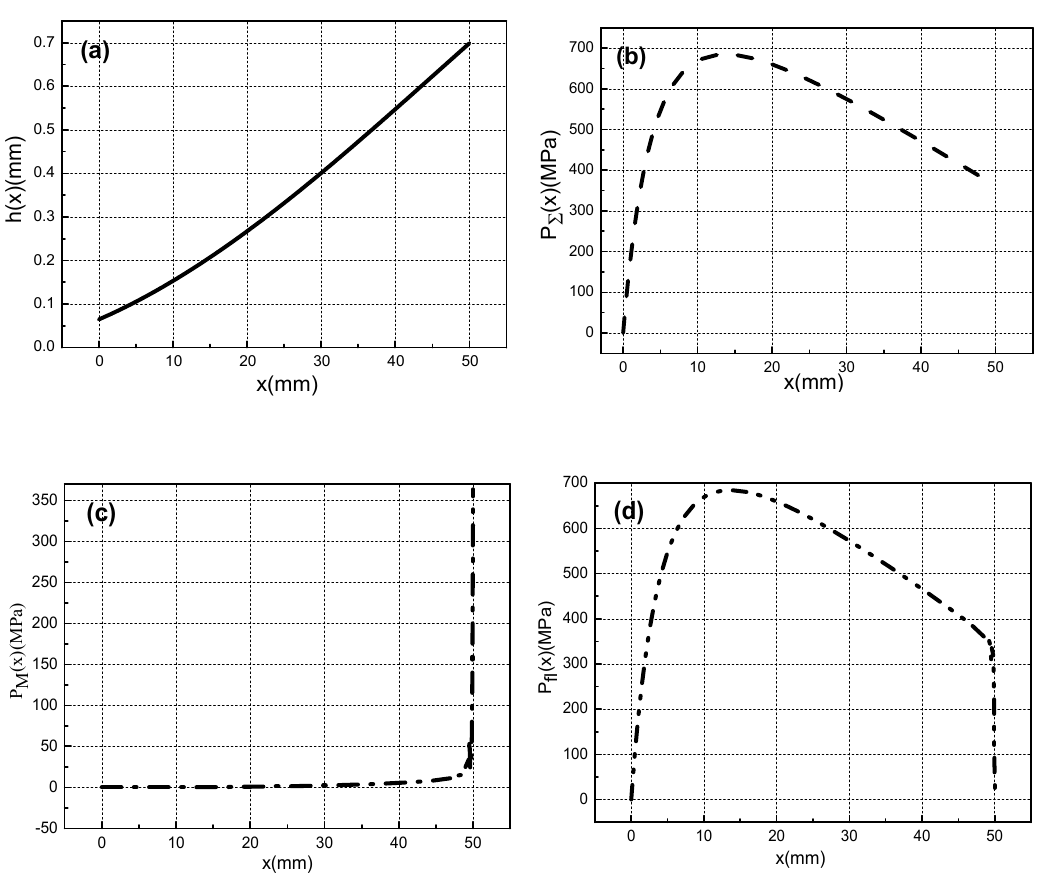
Figure 7. Lubrication characteristics of metal liquid film when the armature movement velocity is 1600 m / s: ( a ) Film thickness distribution, ( b ) Total pressure distribution, ( c ) Magnetic pressure curve, ( d ) fluid